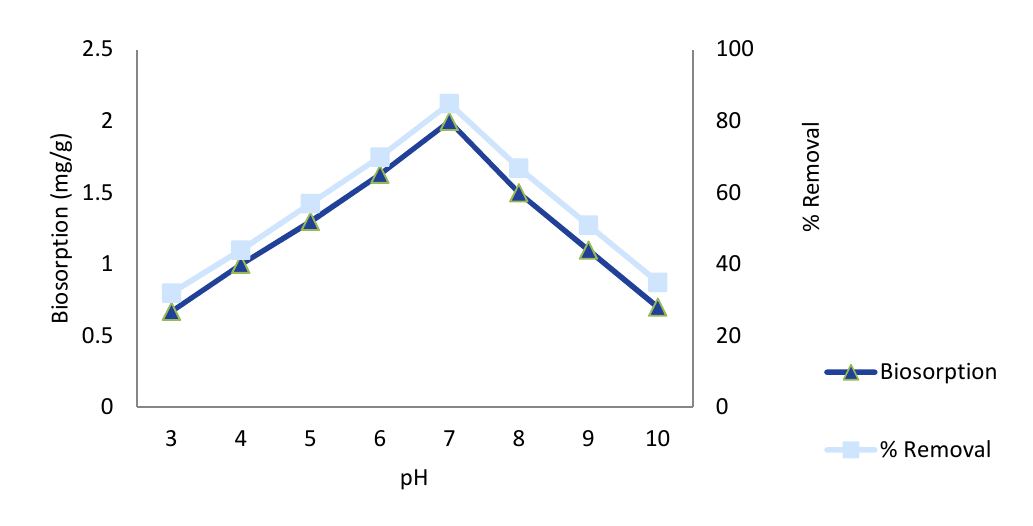
Figure 3. Effect of pH on adsorption